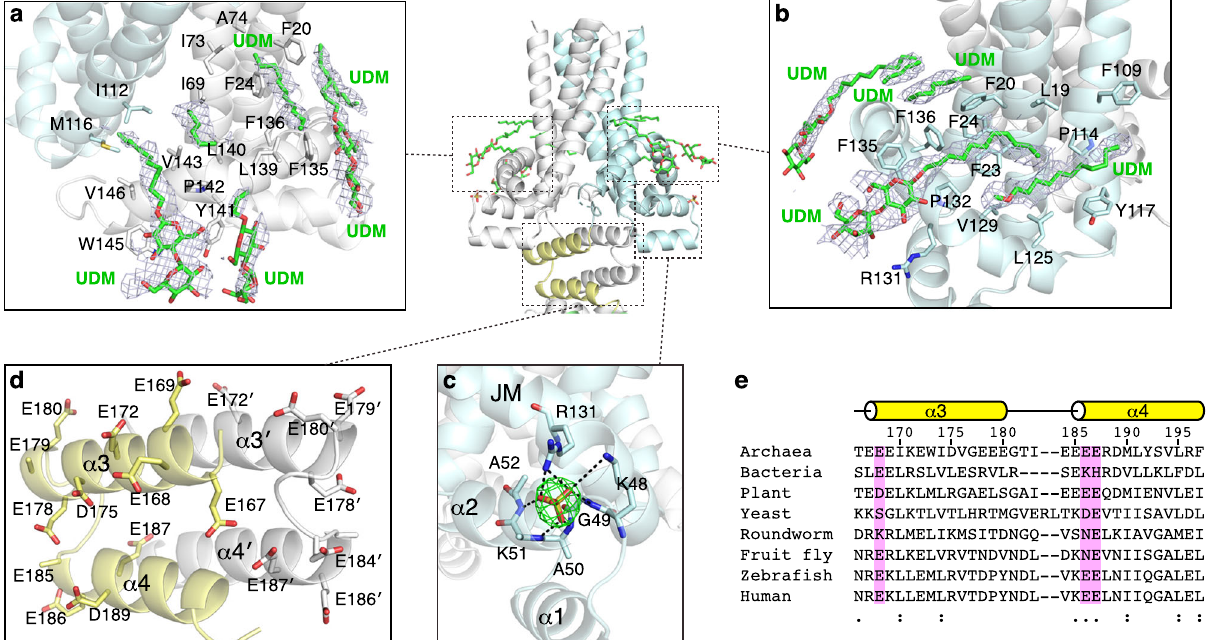
Fig. 3 Juxtamembrane helix and acidic helical bundle. a , b UDM detergent molecules bound by the juxtamembrane helix. Simulated annealing 2 F o – F c composite omit map contoured at 1.0 σ . c A sulfate ion bound between JM and helix – turn – helix motif with F o – F c omit map contoured at 5.0 σ . d Conservation of acidic residues in the AHB domain. e Sequence conservation of conserved glutamates in the